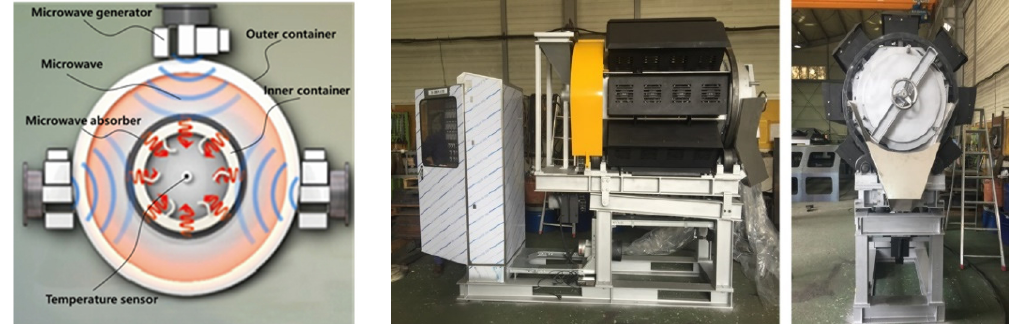
Figure 3. Indirect-heated microwave thermal desorption equipment. Table 4. Design specifications of indirect-heated microwave thermal desorption equipment.